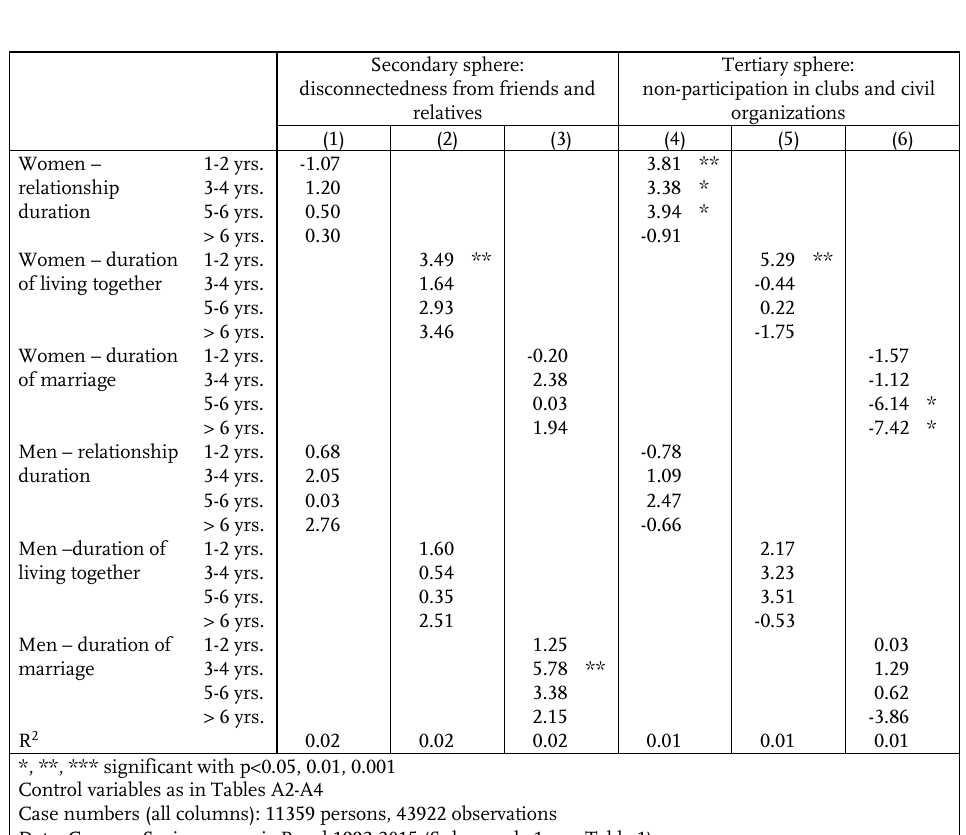
Table A.6 : Time-effects of partner relationships on social isolation (linear-probability models with fixed effects, percentage points)